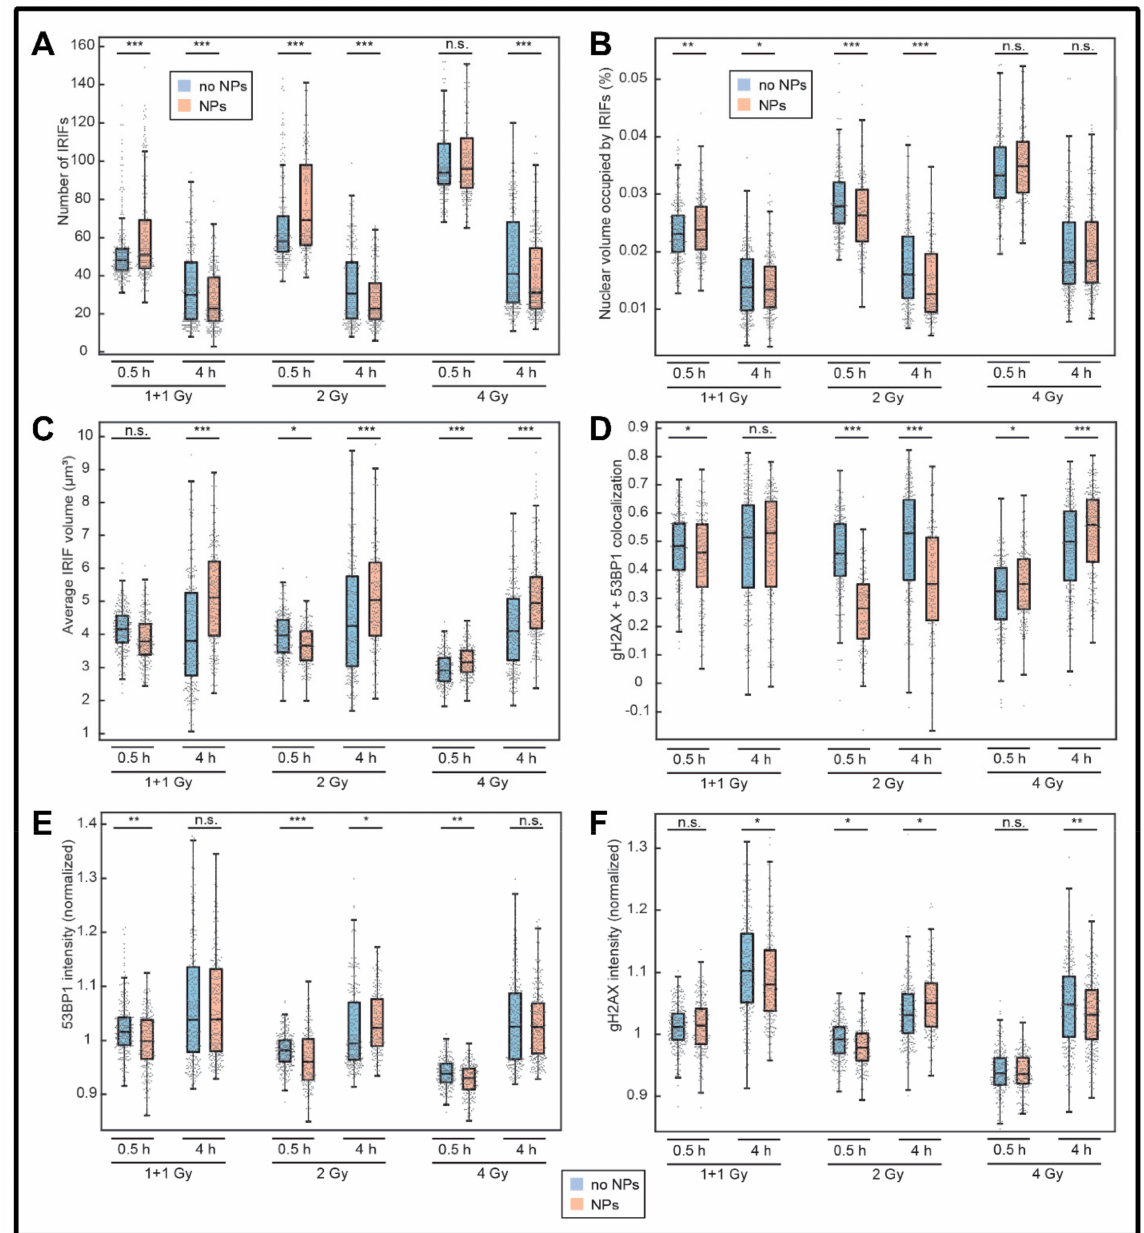
Figure 5. Morphology of DSB [ γ H2AX+53BP1] repair foci compared at the microscale for SkBr3 cells exposed to 1 + 1, 2 or 4 Gy of γ -rays in the presence ( orange ) or absence ( blue ) of GNPs (0.4 µ